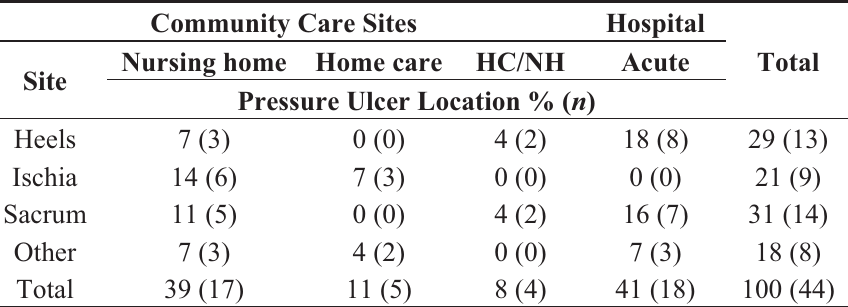
Table 3. Pressure ulcer